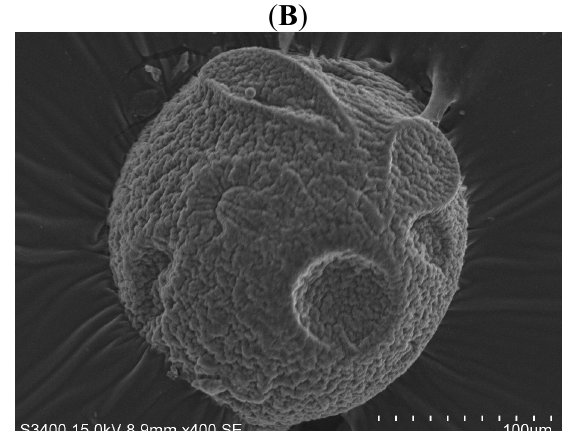
Figure 3. Pictures of chitosan microparticles in scanning electron